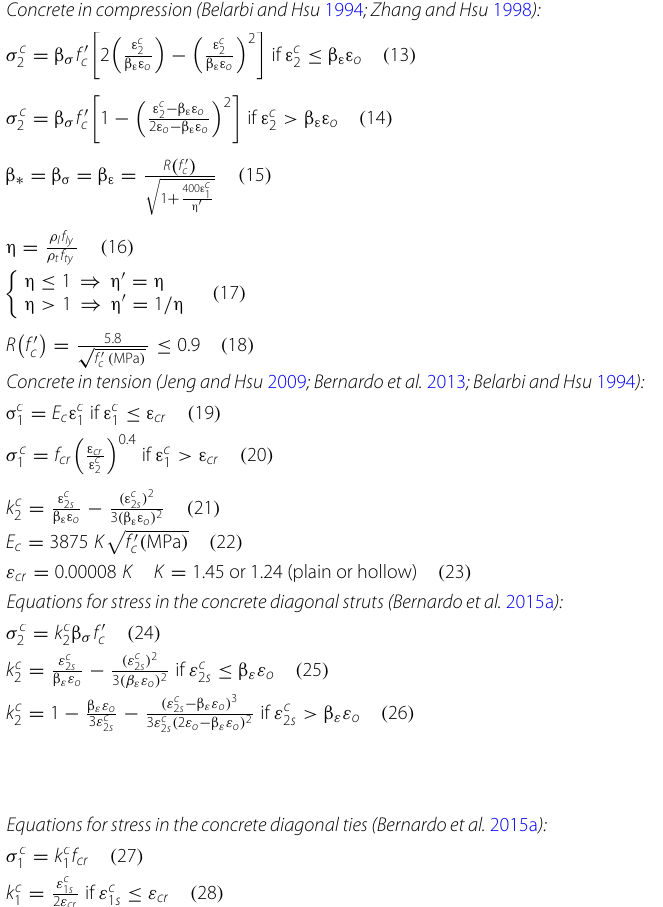
Table 2 σ − ε relationships for concrete and steel. Concrete in compression (Belarbi and Hsu 1994 ; Zhang and Hsu 1998 ): 2 ε c 2 ε c 2 − 2 if ε c 2 ≤ β ε ε o ( 13 σ c 2 = β σ f ′ c β ε ε o (cid:29) β ε ε o (cid:29) (cid:31) (cid:28) (cid:30) (cid:30)